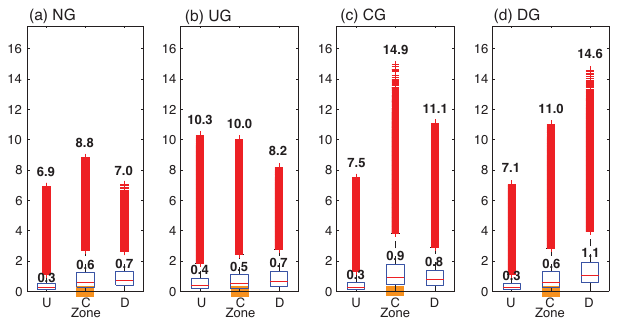
Figure 10. As in Fig. 8 but for TKE (m 2 s − 2